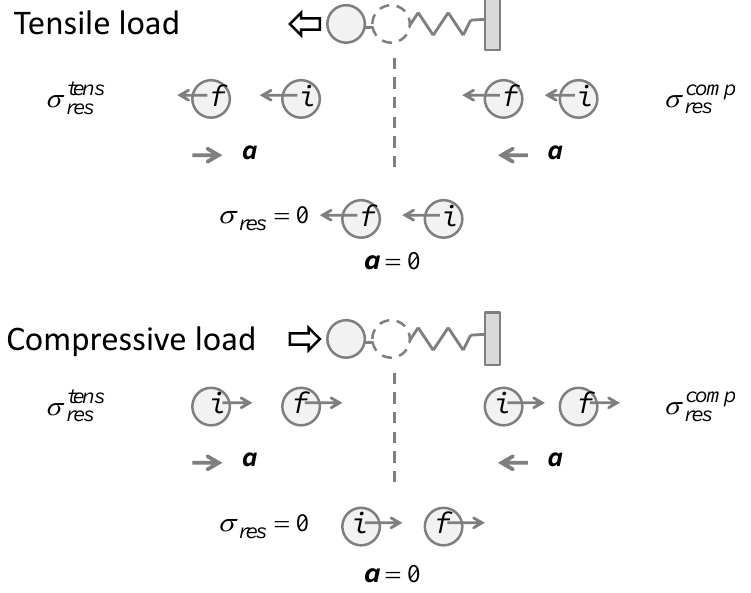
Figure 2. Spring-mass model to represent residual stresses and external